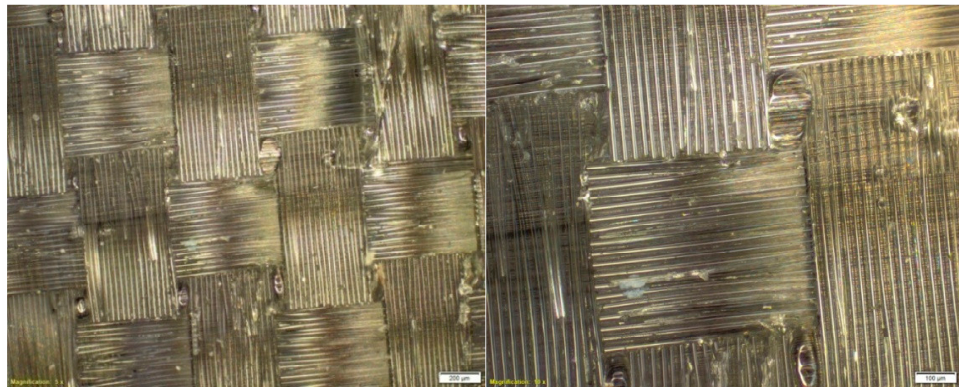
Figure 3. Microstructure of a composite laminate with Roving IMS65 reinforcement [32].